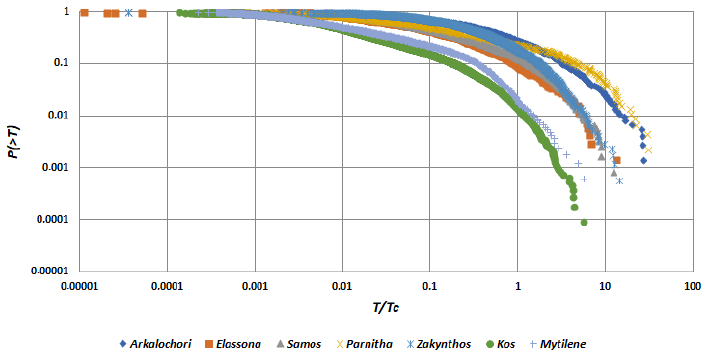
Figure 10. The interevent times distribution P (> x ) for all the studied aftershock sequences as a function of x = T/T c . Deviations from the Q -exponential operation are pronounced at T/T c >> 1, for all sequences.